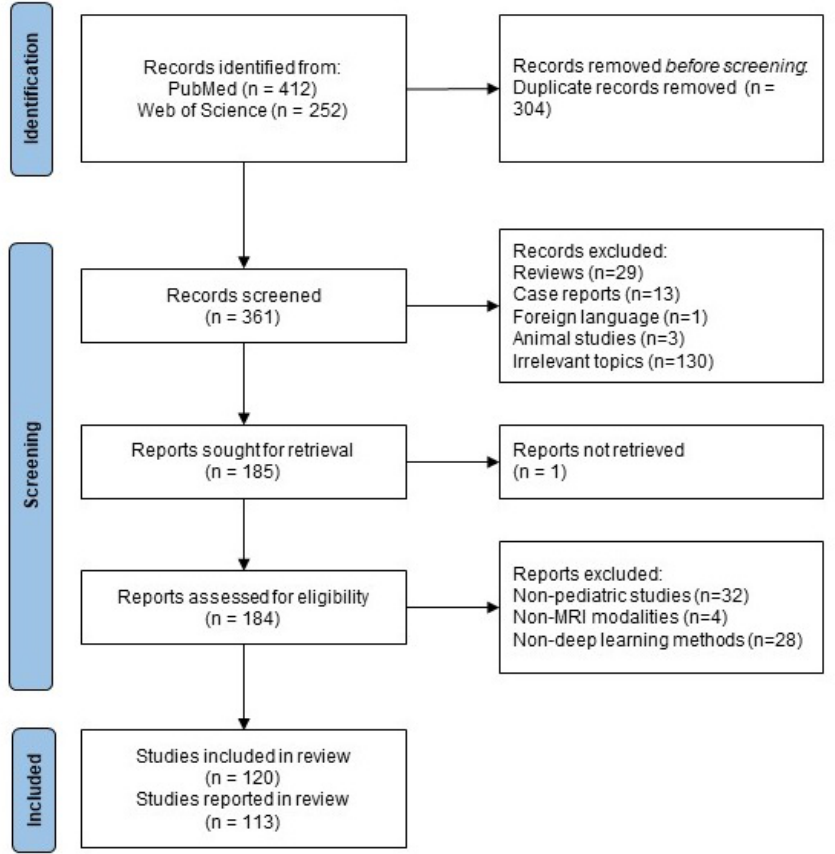
Figure 6. Study selection